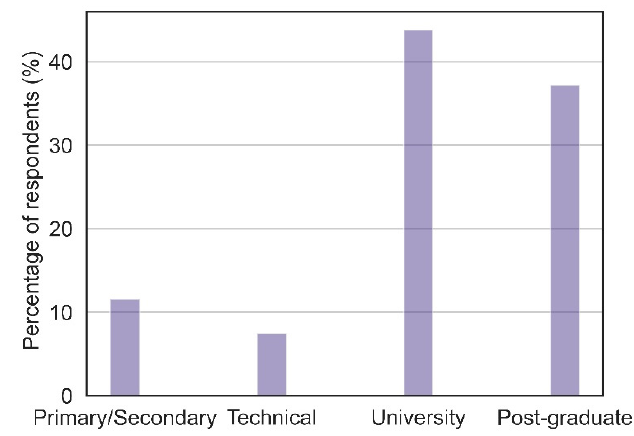
Figure 3. Education level of the respondents.